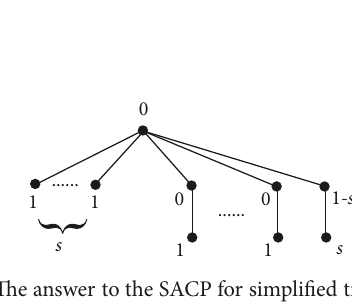
Figure 10: The answer to the SACP for simplified tree 𝑇 󸀠 when 𝑠 < 𝑘 󸀠